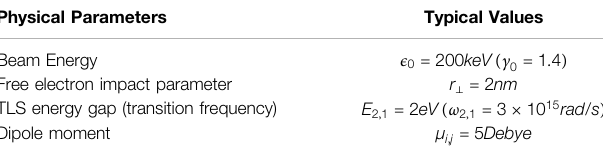
shape of the interaction strength as a function of time when the dipole moment is oriented longitudinally ( Figure 2A ), and its symmetry when it is oriented vertically ( Figure 2B ).